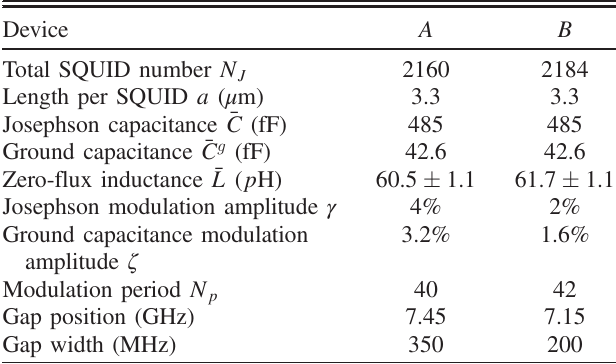
TABLE I. Parameters of samples A and B . The main difference is the modulation amplitude γ , which reflects directly in the width of their photonic